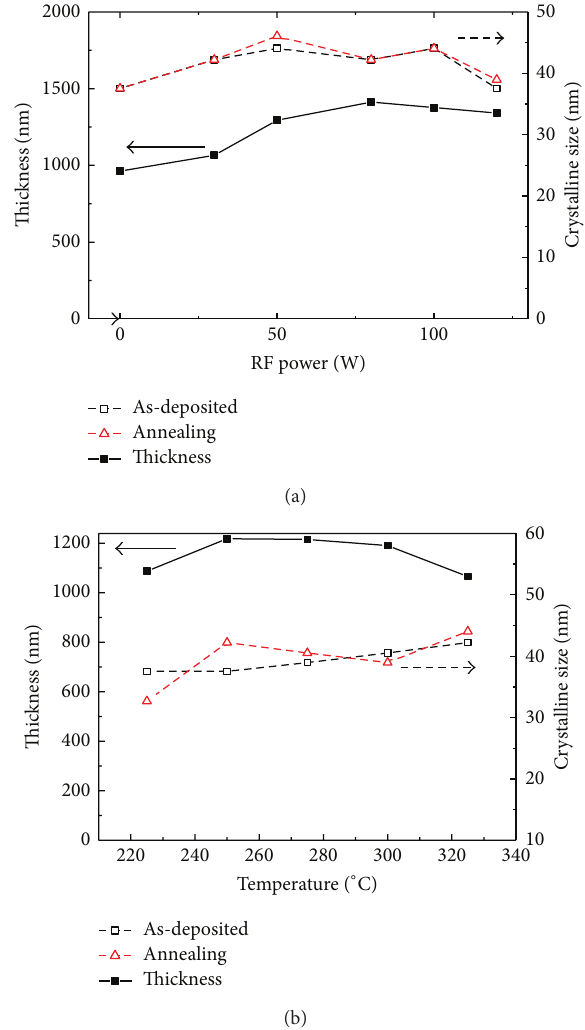
Figure 2: The thickness and the crystalline size for the sputtered AZO films versus (a) the incident RF power and (b) the substrate